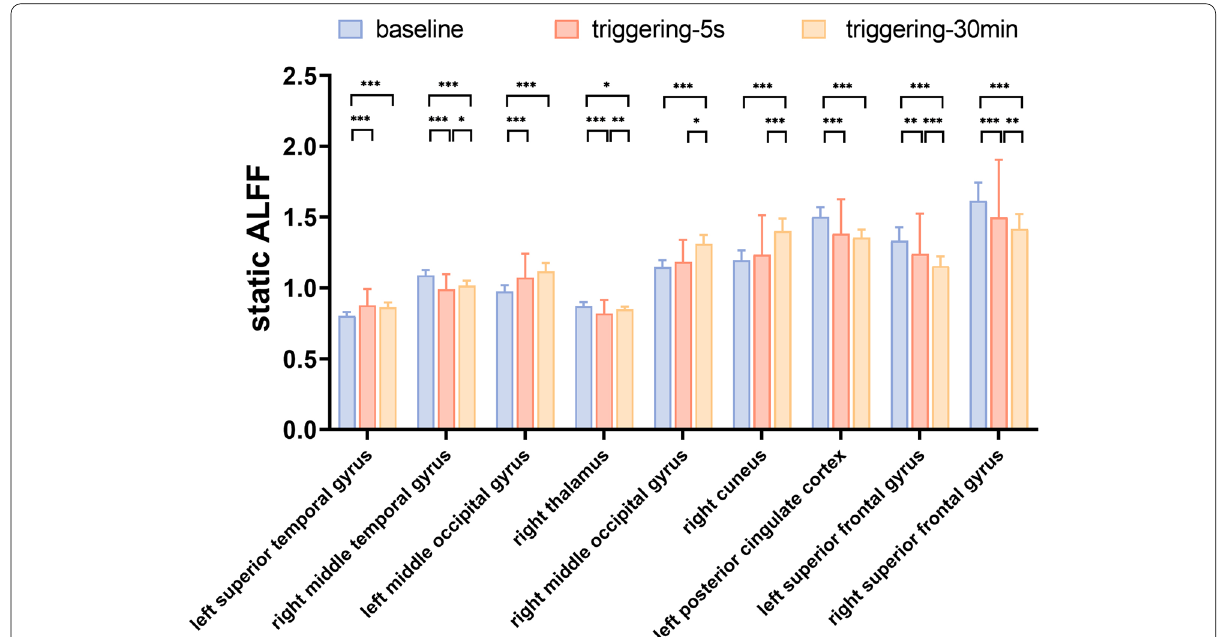
Fig. 3 Post hoc comparisons of analysis of variance. The connection between two bars represents significant between-time differences of sALFF (*represents significant level P < 0.05, **denotes significant level P < 0.01, and *** indicates significant level P < 0.001, Bonferroni correction). ALFF, Amplitude of low-frequency fluctuation; sALFF, static amplitude of low-frequency fluctuation; baseline, the rs-fMRI was performed before stimulating the trigger zone; triggering-5s, the rs-fMRI was performed within 5 s after stimulating the trigger zone; triggering-30min, the rs-fMRI was performed in the 30th minute after stimulating the trigger zone Table 3 The correlation between the different brain regions in sALFF and the VAS, duration among different times after triggering the pain in patients with